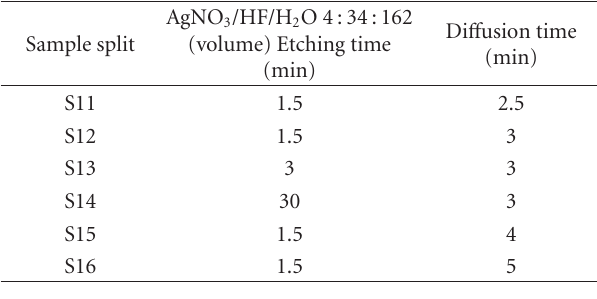
Table 1: Various AgNO 3 and HF concentrations in AgNO 3 /HF/H 2 O mixture chemical solutions, as well as etching time, were employed to explore various surface morphologies of SNWs formed on the p-type Si(100) substrate.